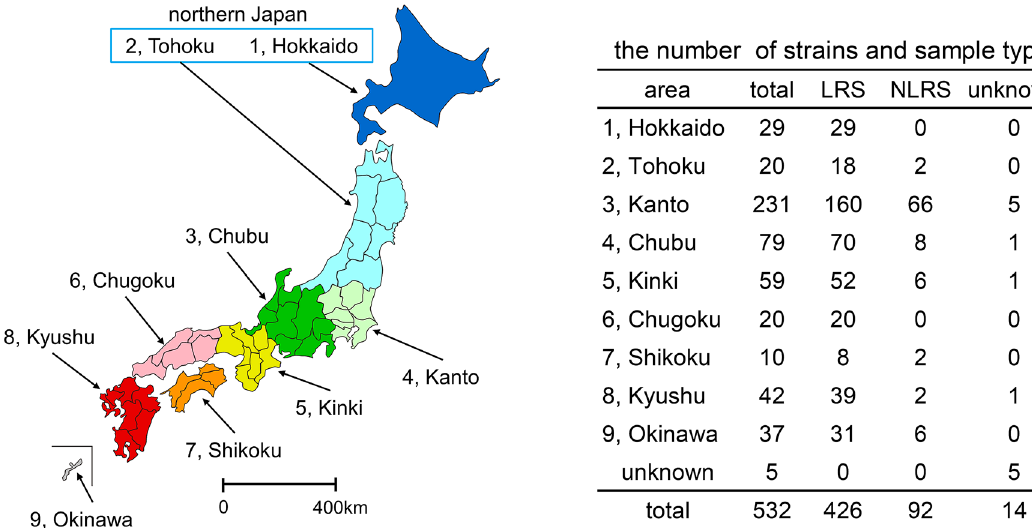
Figure 4. Distribution of rapidly growing mycobacteria (RGM) strains in different regions of Japan. Japan was divided into nine regions. Hokkaido and Tohoku were defined as Northern Japan. This map was created by Keisuke Kamada at the following site (https ://n.freem ap.jp/). The copyright of the completed map is held by Keisuke